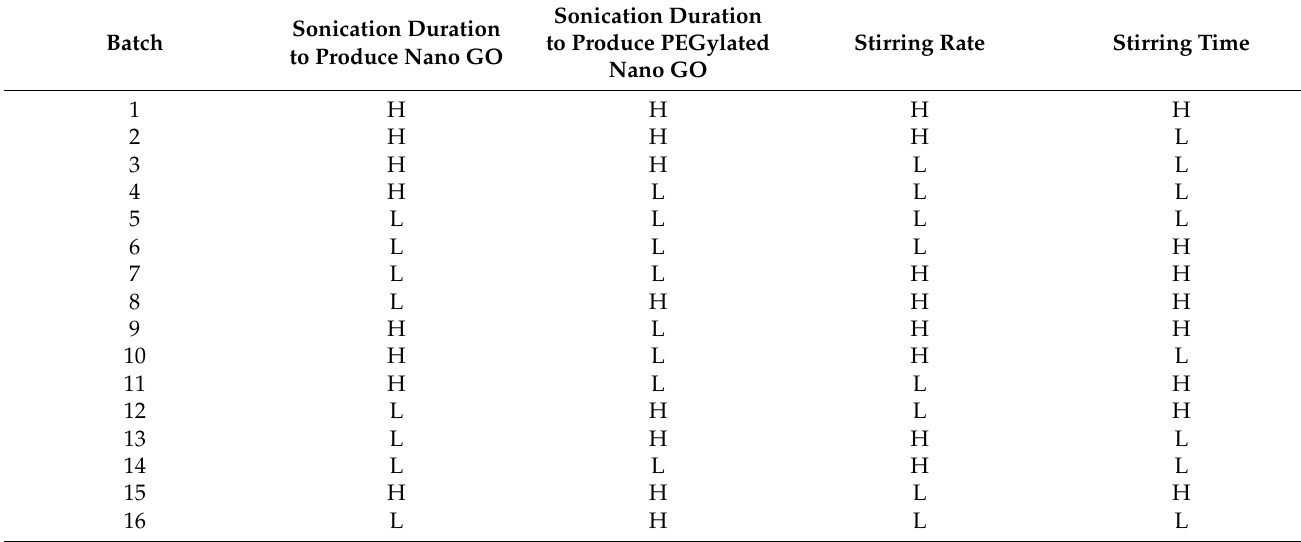
Table 2. Design of experiment (DoE) for the preparation of acetaminophen (AMP)-loaded PEGylated nano graphene oxide (NGO) batches.